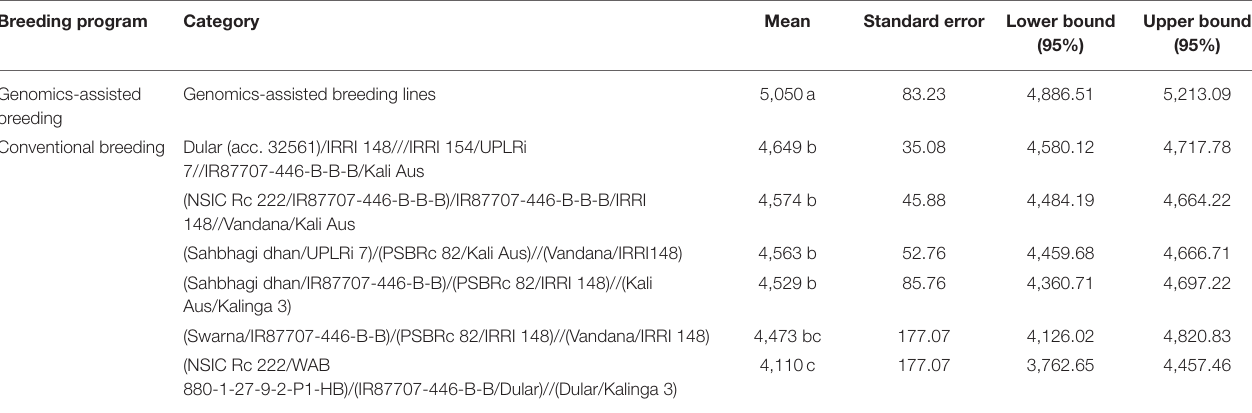
TABLE 6 | Analysis of the differences for grain yield (kg ha − 1 ) at the F 6 generation in the dry season between the categories of breeding lines (with a confidence interval of 95%) developed following genomic assisted breeding and conventional breeding approaches. Breeding program Category